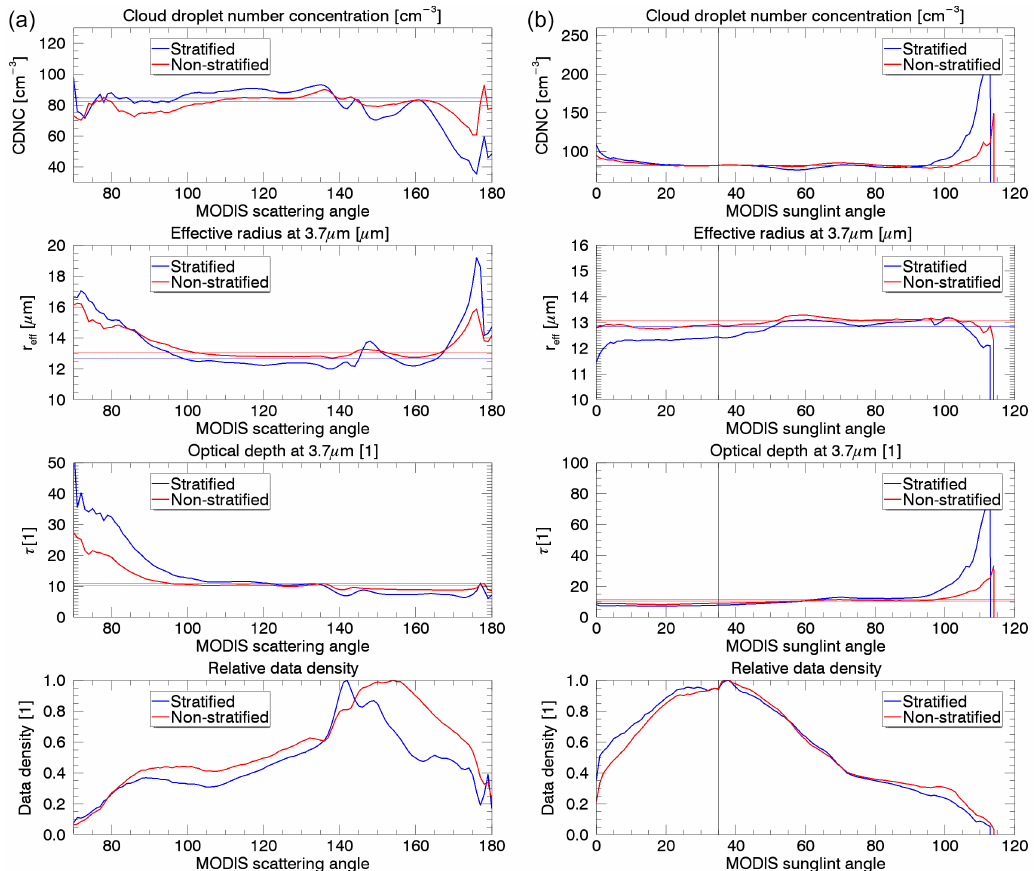
Figure 4. Dependency of retrieved CDNC, effective radius, and optical depth, all at 3.7µm, on scattering angle (a) and sunglint angle (b) of Aqua-MODIS observations. The curves show global annual averages for the year 2008. See Table 1 for terminology regarding “Stratified” and “Non-stratified”. The vertical line in the right panels shows the sunglint angle below which the MODIS cloud masks flag a sunglint contamination. The horizontal red and blue lines are the average retrieved values over the entire